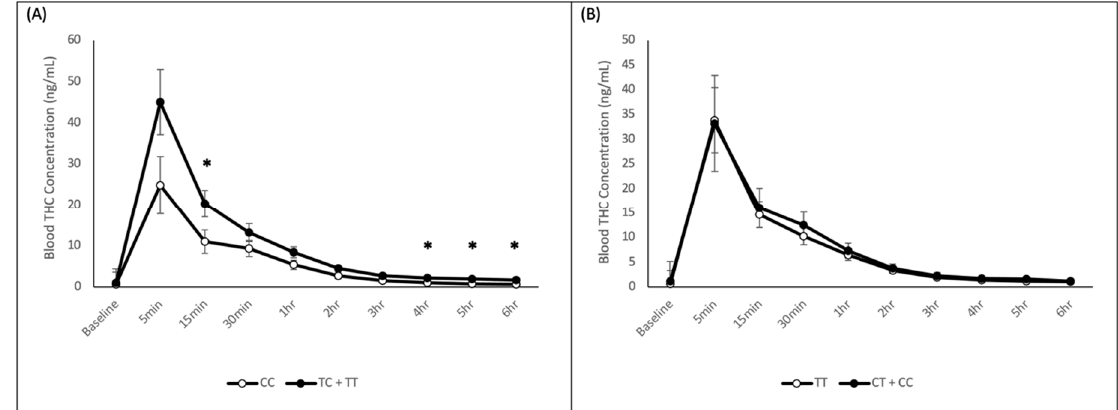
Figure 1. CNR1 rs1049353 and rs2023239 Blood THC Concentration. Time course of mean blood THC concentrations of major allele and minor allele-carrying groups for the ( A ) rs1049353 and ( B ) rs2023239 polymorphism. * p < 0.05.